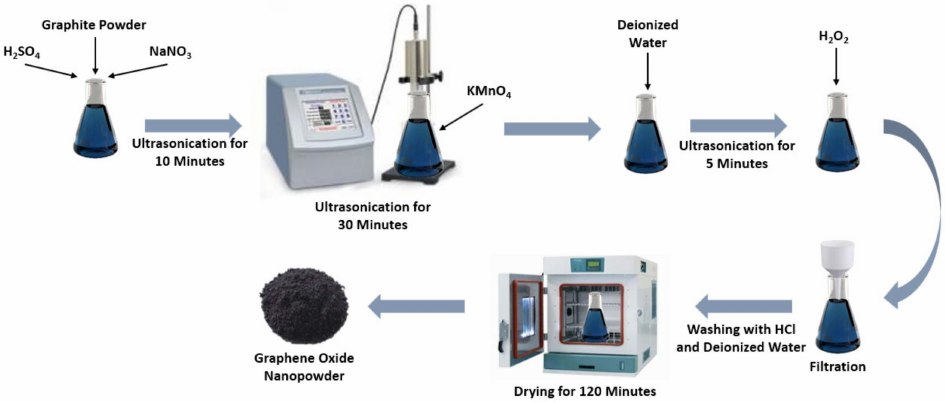
Figure 14. Schematic diagram of the Hummer method for the synthesis of GO.